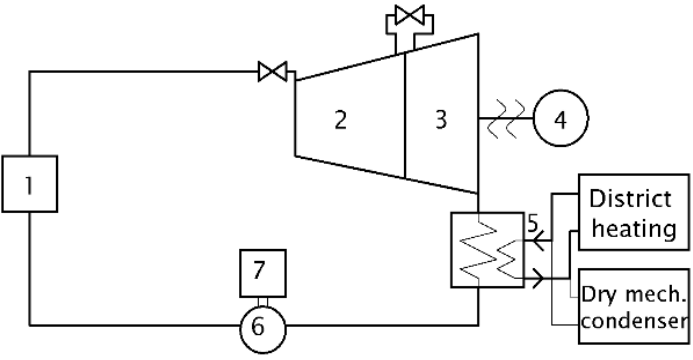
Figure 8. Basic topology of the BPT cycle in the Pilsen CPP [5].